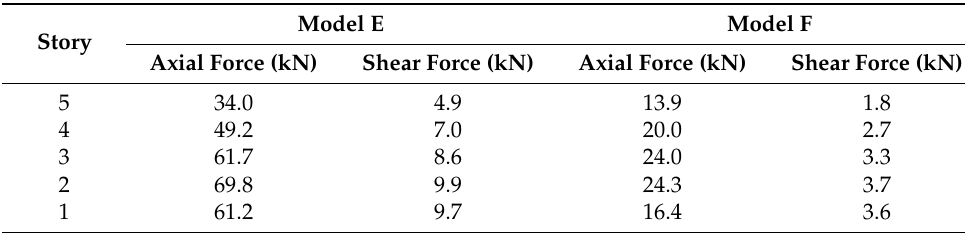
Table 6. A comparison of the internal force of the stair columns.